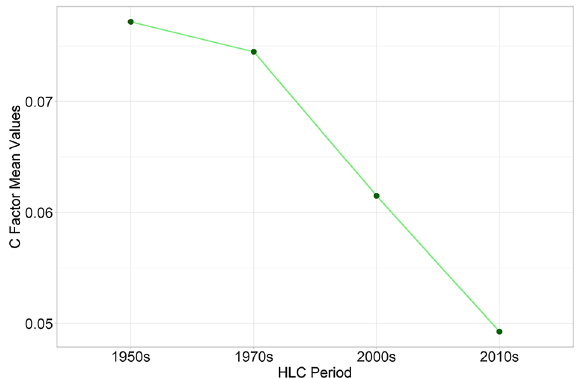
Figure 7. The C factors mean values in the four chronological periods: 1950s, 1970s, 2000s, 2010s). Image generated with software RStudio Desktop 2022.07.2 + 576 (https:// www. rstud io. com/).